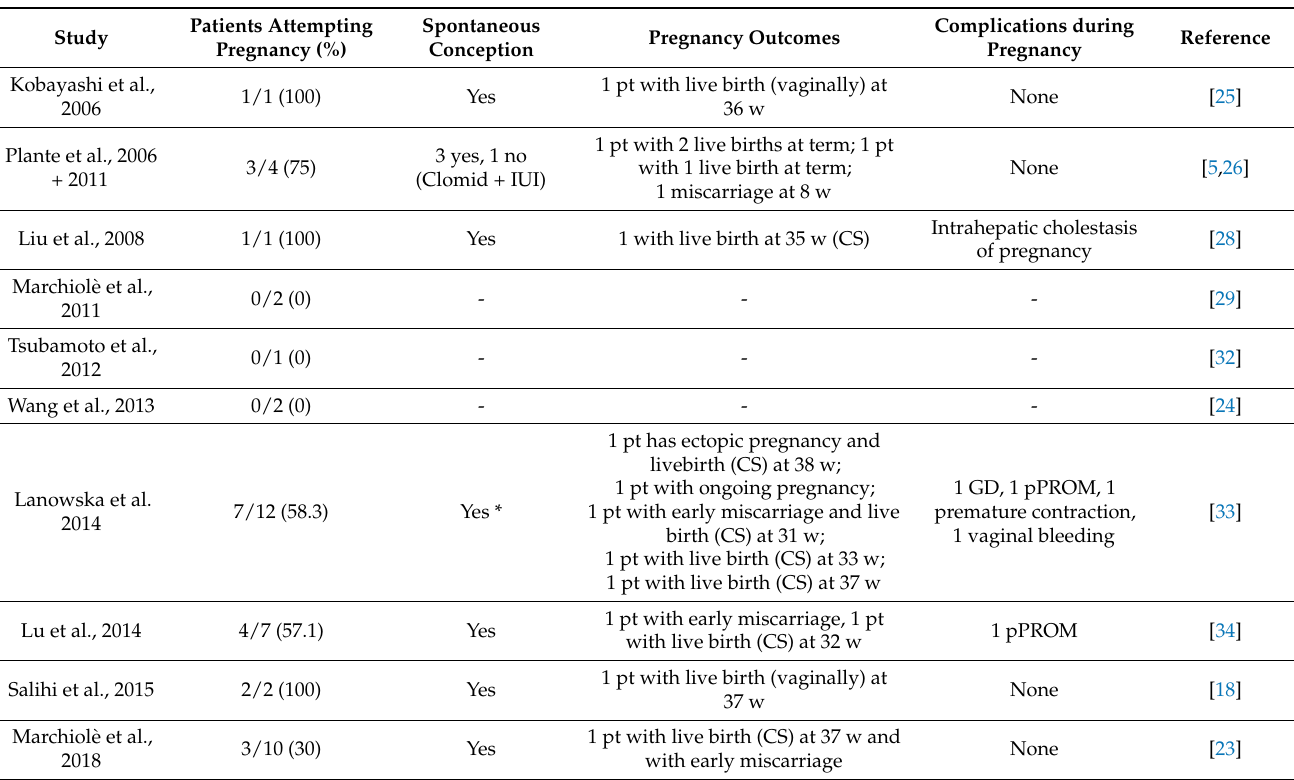
Table 4. Obstetrical outcomes among women who completed the fertility-sparing